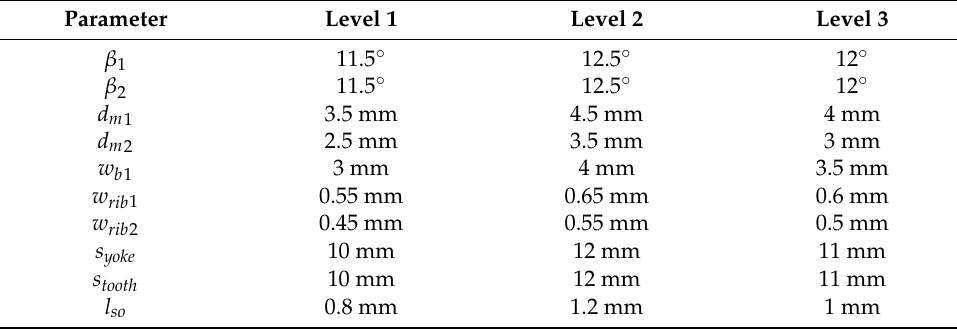
Table 3. Exams Table.